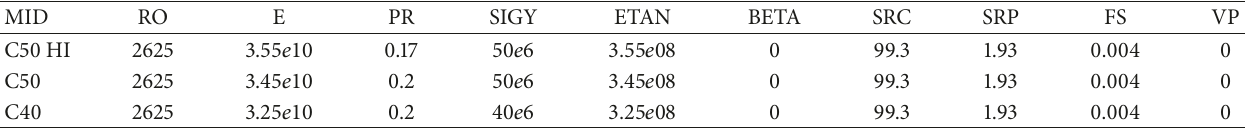
Table 1: The parameters of concrete material model.